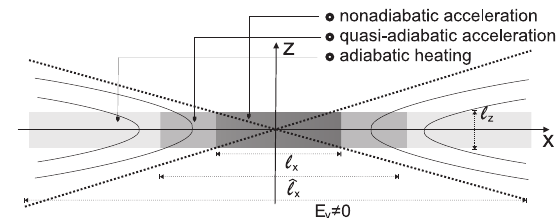
Fig. 1. Scheme of the modelling